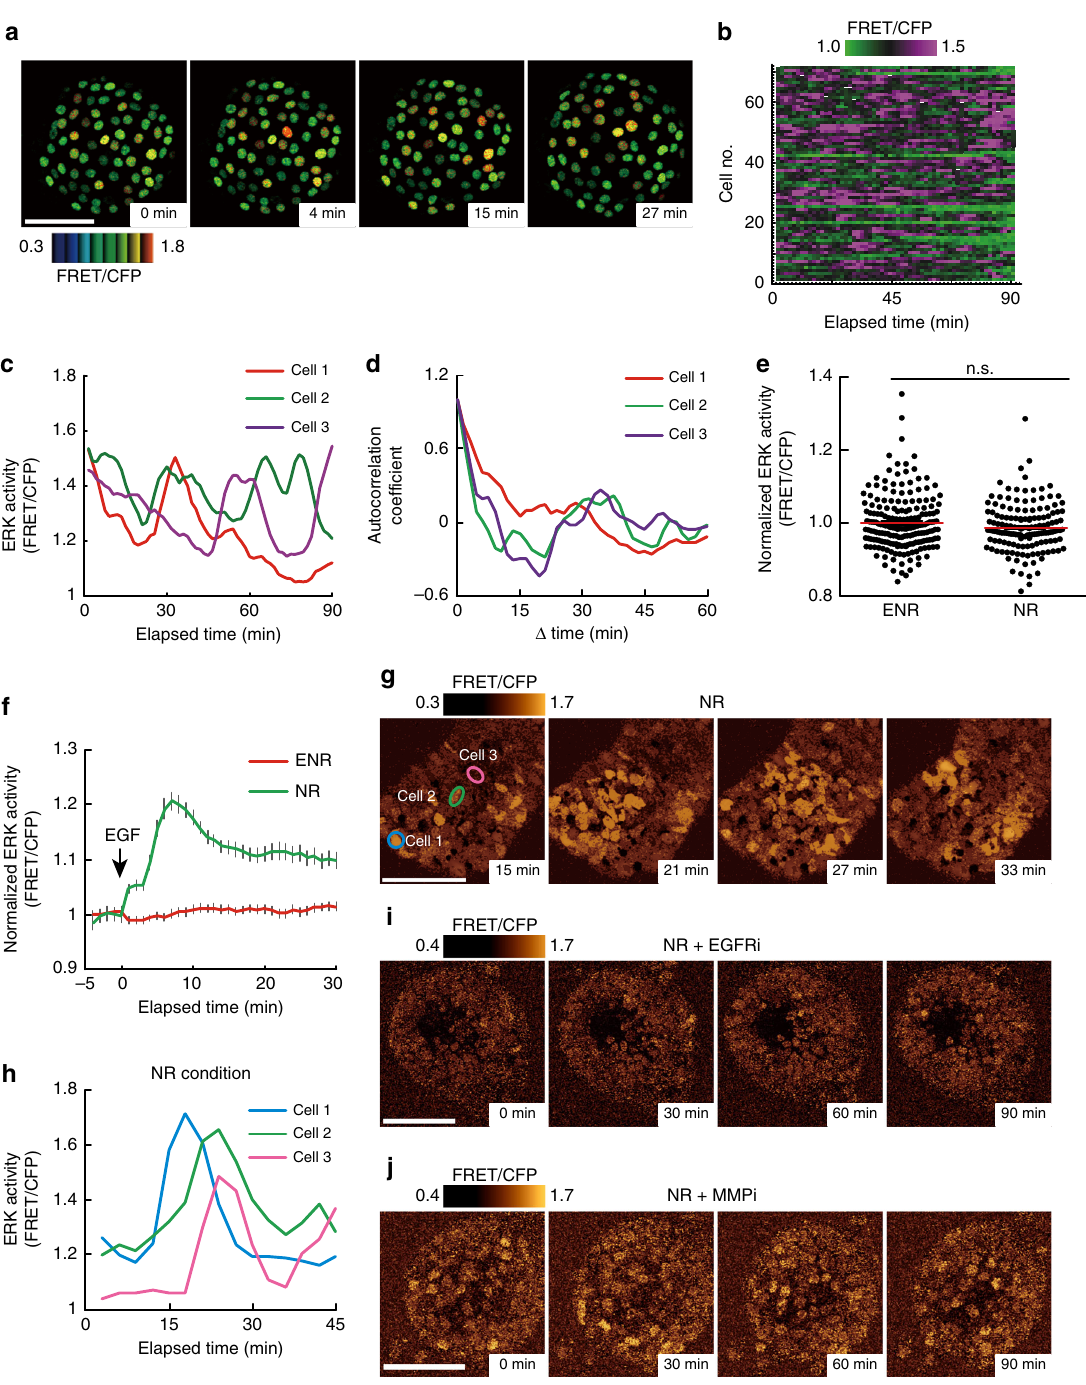
Fig. 3 Spontaneous pulse-like ERK activation and propagation of ERK activity in intestinal organoids. a – d Time-lapse imaging of the EKAREV-NLS organoids was performed for 90 min at 1.5 min intervals ( n = 71 cells). a Representative time-lapse images of ERK activity (FRET/CFP ratio) in an organoid showing pulse-like ERK activation. b Heat map showing the time course of ERK activity (FRET/CFP ratio) in each cell. c Time courses of ERK activity in three representative cells. The original data before smoothing by the moving average are shown in Supplementary Fig. 2c. d Temporal autocorrelation coef fi cients of ERK activity in the three cells shown in c . e , f Time-lapse imaging of the EKAREV-NLS organoids cultured under EGF-starved conditions for 24 h. e Bee swarm plots of ERK activity in organoids cultured under the normal condition (ENR) or EGF-starved condition (NR) ( n = 193 and 148 cells pooled from three organoids). f Time course of the average ERK activity in the control or EGF-starved organoids after stimulation with EGF. The organoids were cultured under the normal (ENR) or EGF-starved condition (NR), and then stimulated with 50 ng ml − 1 of EGF at time point 0 (ENR: n = 129, NR: n = 59 cells). g Representative time-lapse images of an organoid cultured under the NR condition showing propagation of ERK activity. ERK activity (FRET/CFP ratio) is shown in golden pseudo colour mode. h Time courses of ERK activity in the three representative cells marked in g . i , j Representative time-lapse images of organoids treated with an EGFR inhibitor (PD153035, 1 μ M) ( i ) or an MMP inhibitor (marimastat, 100 μ M) ( j ). Organoids were cultured in NR media for 24 h, and subsequently treated with either inhibitor. ERK activity is shown in the golden pseudo colour mode. Scale bars, 50 µ m. Red lines represent mean. Error bars represent s.e.m. Mann – Whitney U -test was used for comparison ( e ). * P < 0.05, ** P < 0.001, *** P < 0.0001, n.s., not signi fi